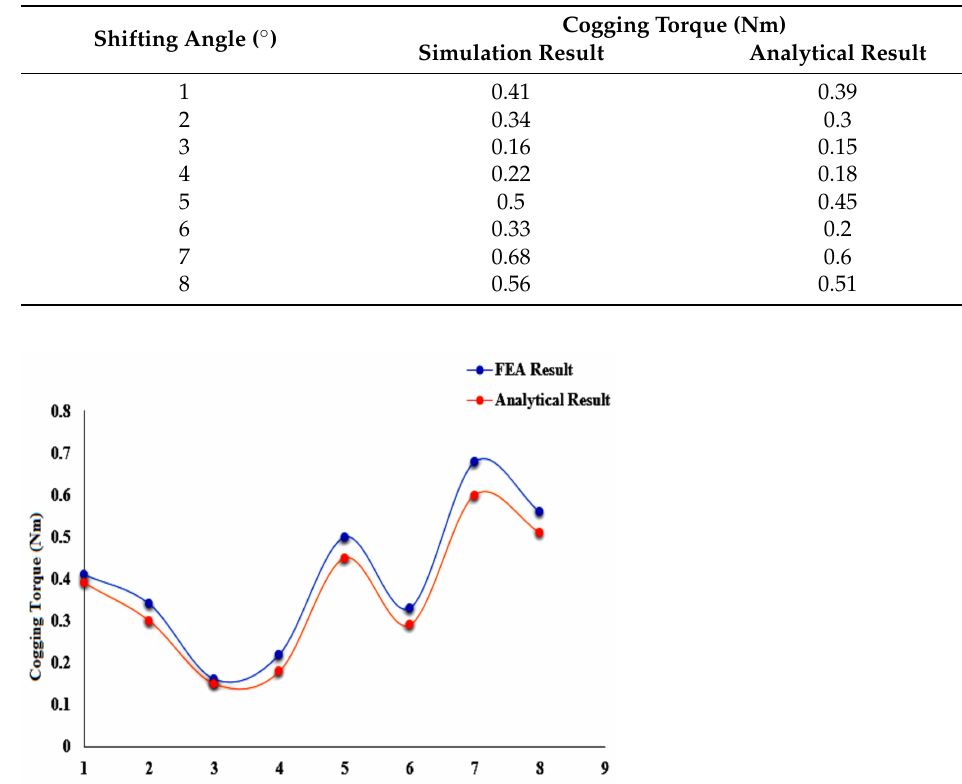
Table 7. Comparison of simulation and analytical result.